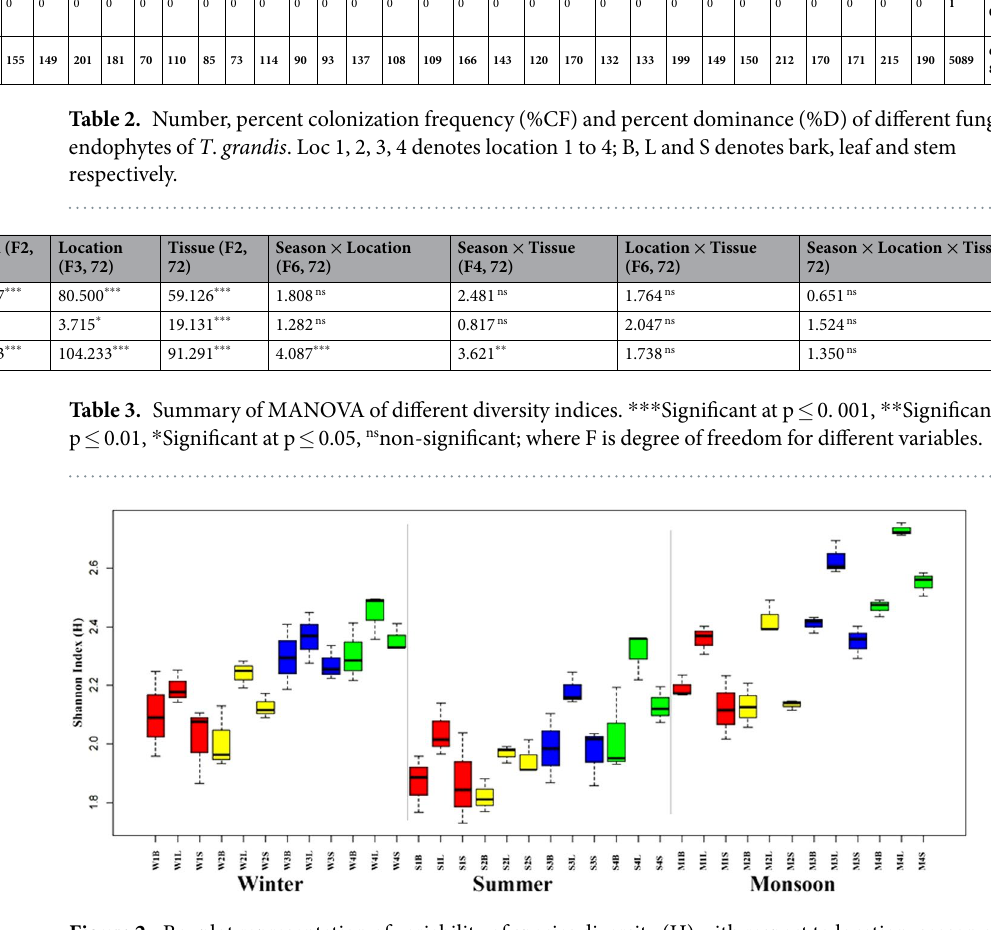
Figure 2. Boxplot representation of variability of species diversity (H) with respect to location, season and tissue type. The first letter of the three-letter acronyms denotes the season (W, winter; S, summer; M, monsoon), the second the location and the third the tissue type (B, barks; L, leaf; S, stem).